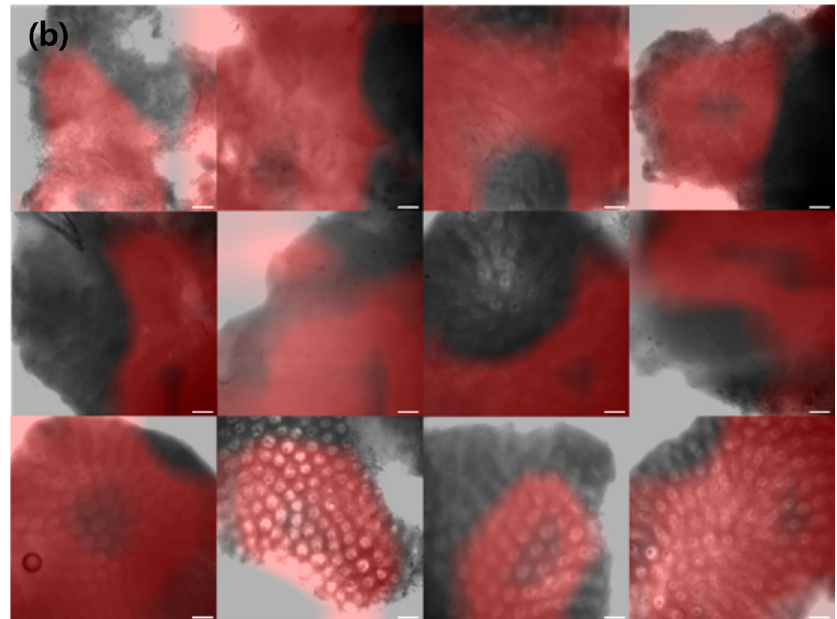
Figure 2. Test data samples ( a ) and the results of class activation map ( b ). Neoplasm examples are shown in the top row, inflammation in the middle row, and normal in the bottom row, respectively. Red arrows on neoplasm images indicate the area where the glands are hard to see, and yellow arrows on normal images indicate where the glands are uniformly represented. The arrangement of gland is an important feature on neoplasm classification task, and it can be seen that CAM focuses well on this area. The white bars on the lower right of the image indicates the scale 50 μ m.